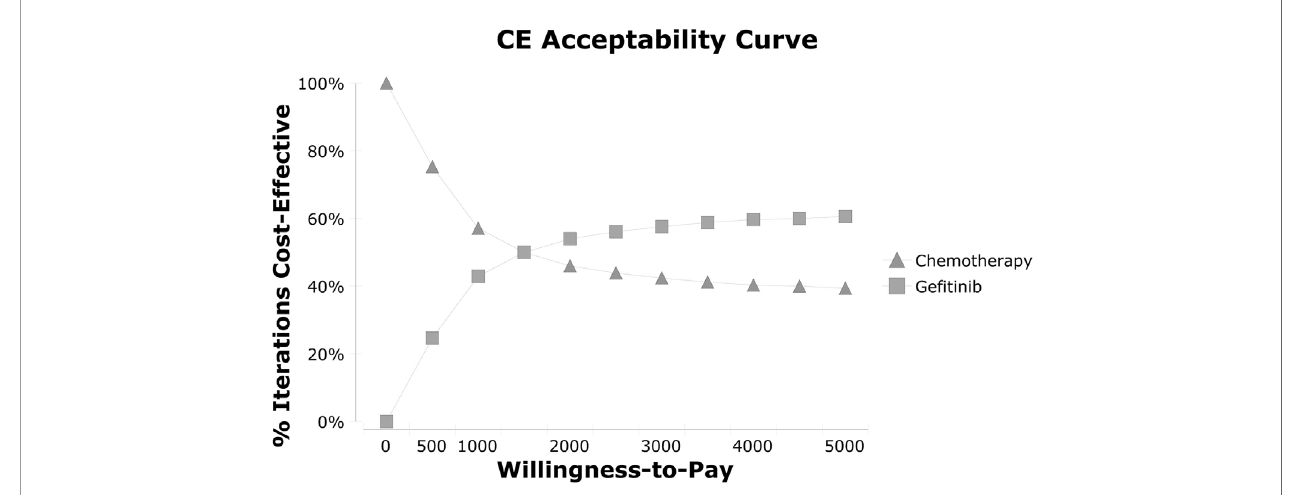
FIGURE 3 | Cost-effectiveness acceptability curve. CE, cost-effectiveness.